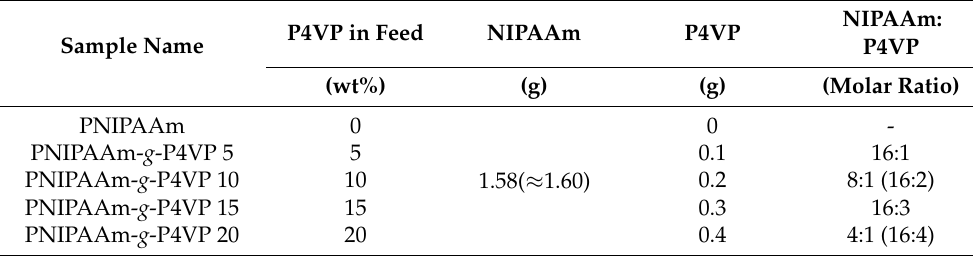
Table 1. The feed ratios of the crosslinking reaction for preparation of PNIPAAm- g -P4VP.